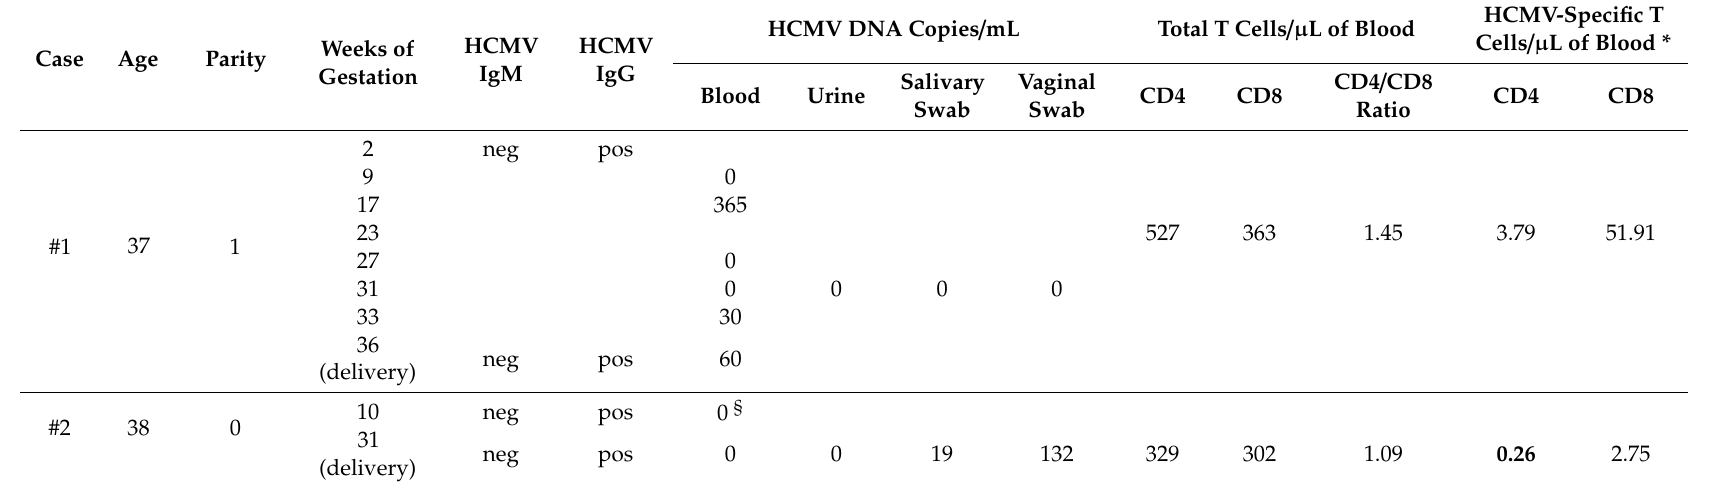
Table 1. Virological and immunological follow-up of human cytomegalovirus (HCMV)